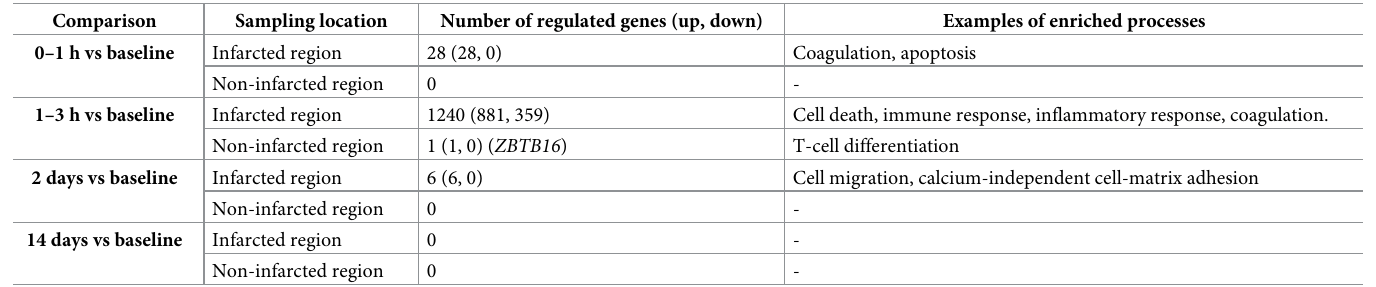
Table 2. Significantly regulated genes and enriched biological processes at different